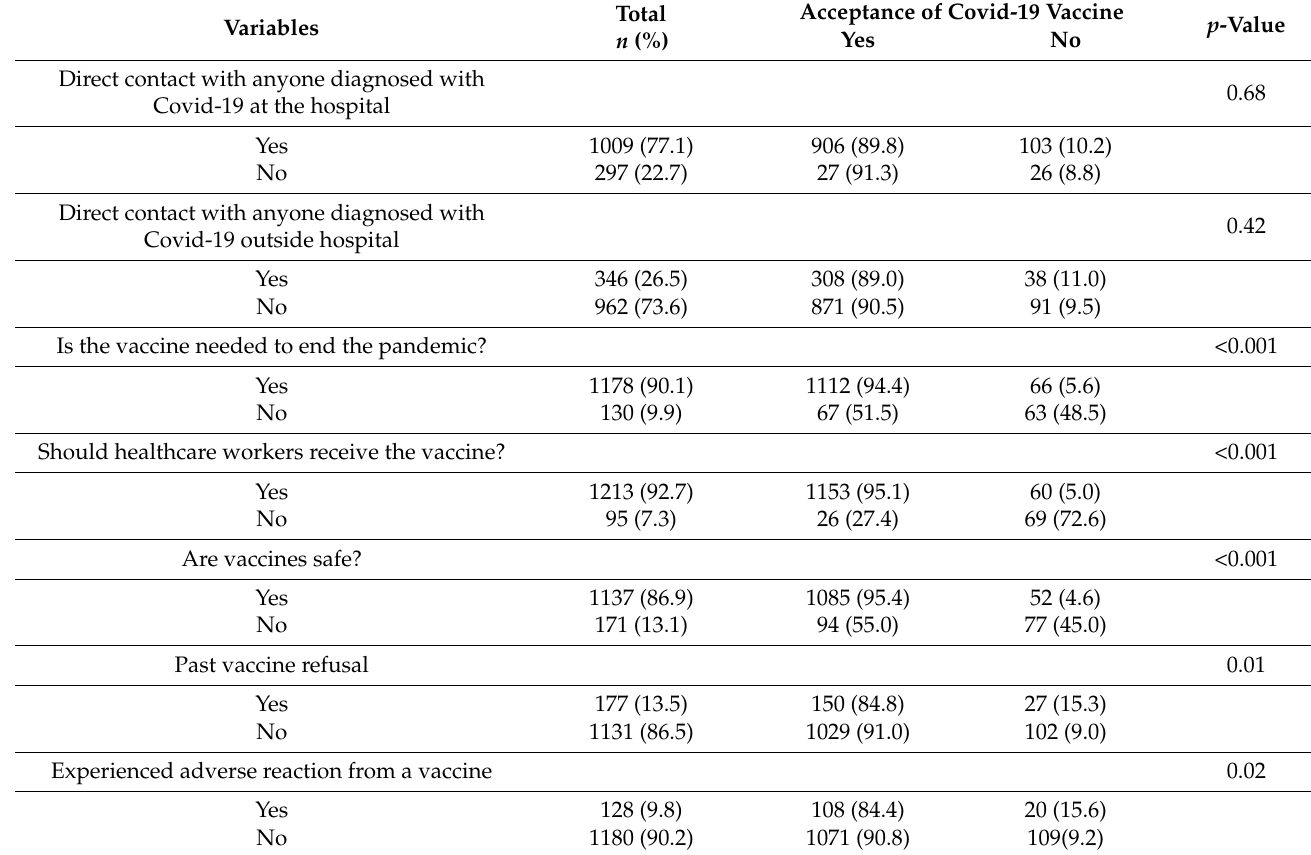
Table 2. Perception of risks, SARS-CoV-2 vaccine and their associations with acceptance. Total Acceptance of Covid-19 Variables